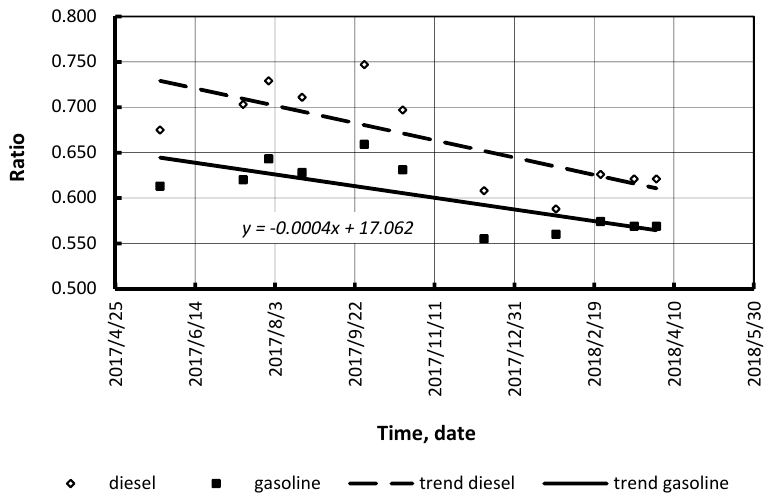
Figure 9. Compressed natural gas (CNG)/conventional fuel prices ratio in Ukraine.